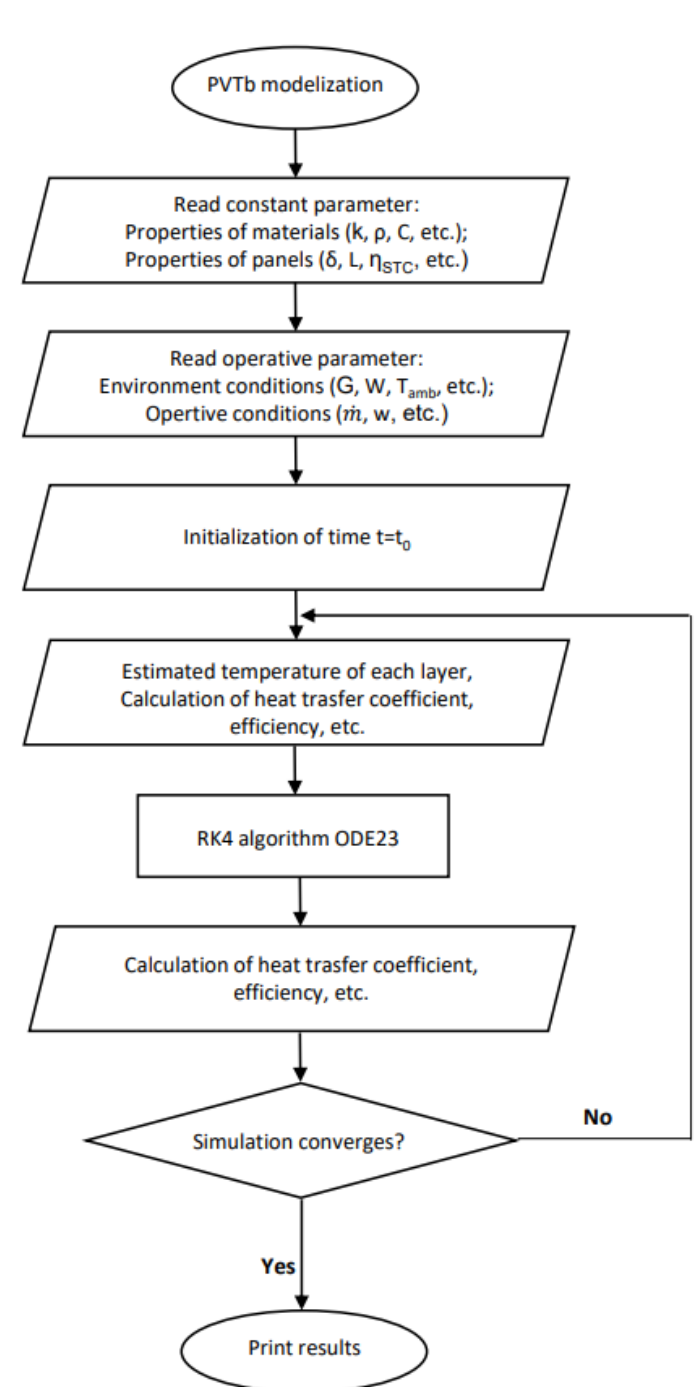
Figure 3. Flowchart of the numerical model.